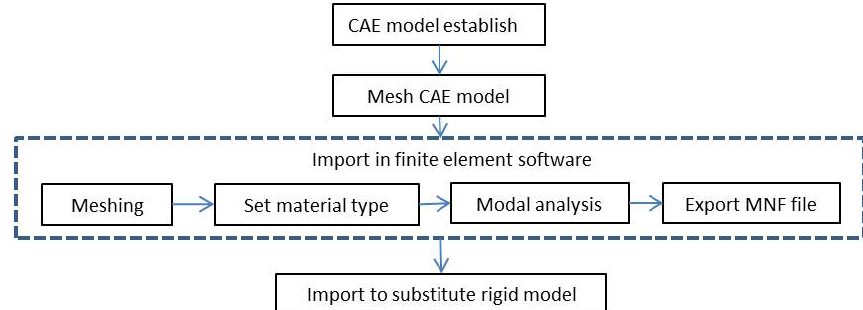
Figure 5. Compliance model processing flowchart.